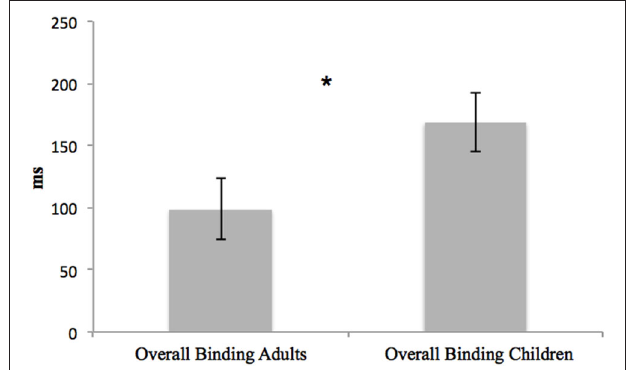
FIGURE 6 | Differences in the voluntary action overall binding between young adults and children . Error bars represent SEM and * indicates the significantly difference in overall binding between the two groups. Only adults present IB effect, showing temporal compression between voluntary action and its